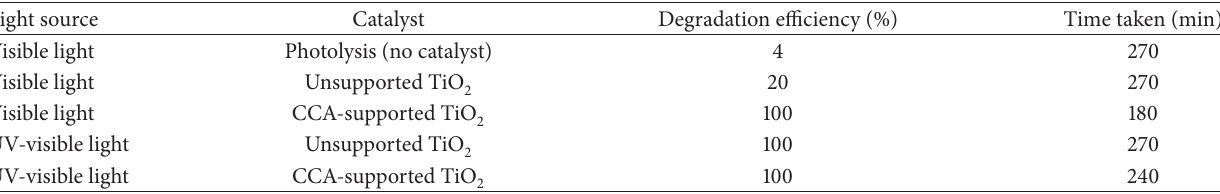
under UV and visible-light illumination. 2